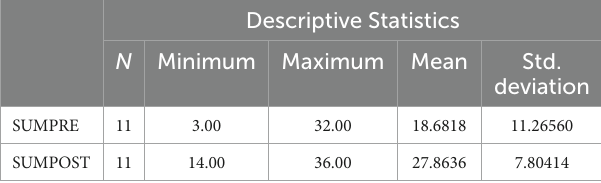
TABLE 5 Descriptive statistics for pre-efficacy and post-efficacy scores for self-guided